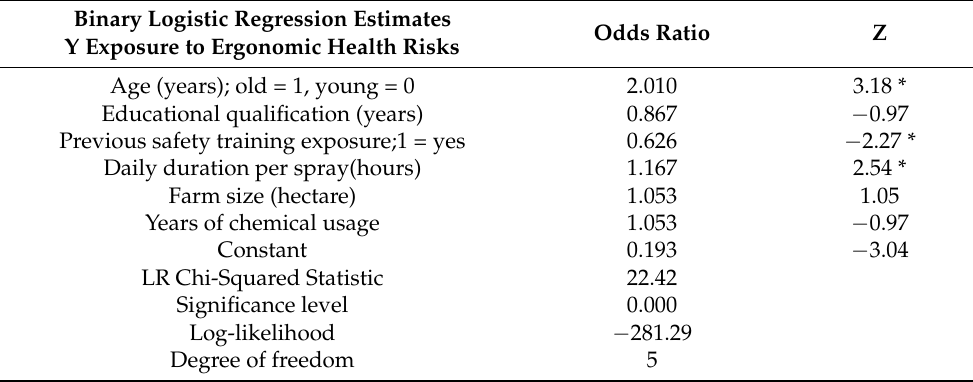
Table 4. Factors predisposing cassava farmers to ergonomic health risks. Binary Logistic Regression